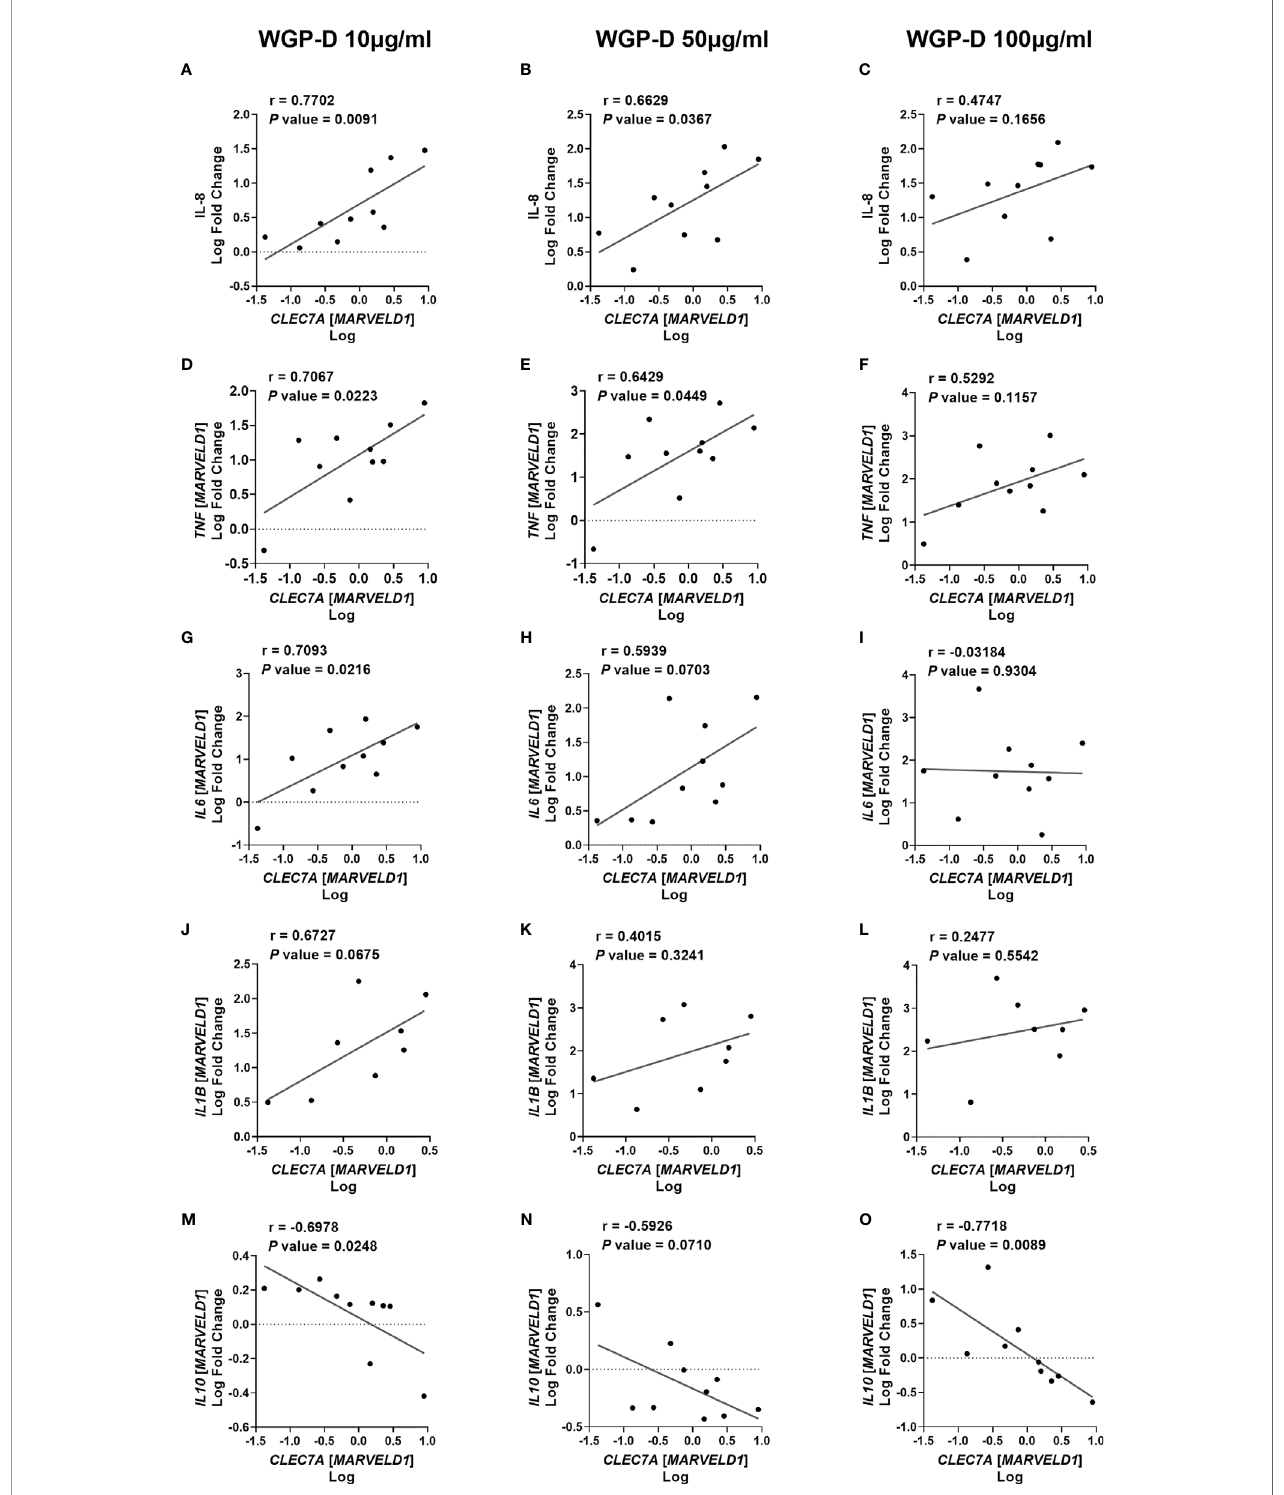
FIGURE 3 | Correlations between CLEC7A mRNA expression and (A – C) IL-8 cytokine production, (D – F) TNF , (G – I) IL6 , (J – L) IL1B , and (M – O) IL10 mRNA expression upon stimulation with 10, 50 and 100 µg/mL of WGP Dispersible, as indicated. Results are presented as Log fold changes of each cytokine relative to medium vs Log CLEC7A mRNA. Data represent simple linear regressions, with Pearson correlation coef fi cients (r) and P